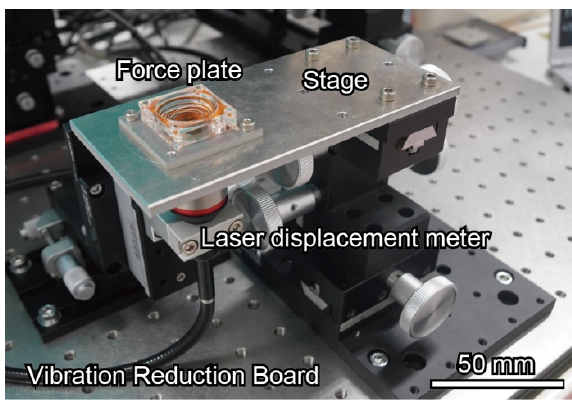
Figure 8. Setup for the calibration and experiment.